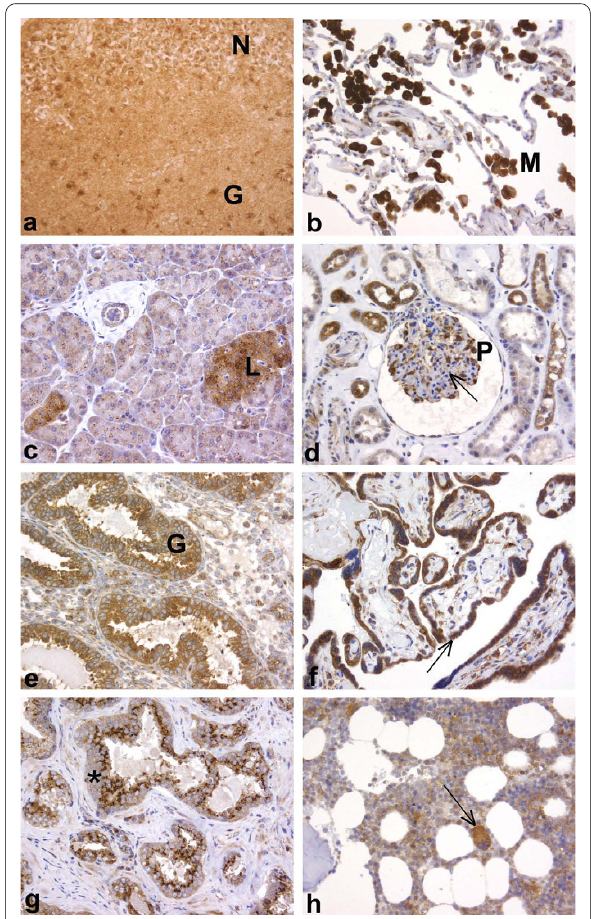
Figure 3 Immunohistochemical analysis of FMNL2 in human tis- sues . a) In the hippocampus, both neurons (N) and glial cells (G) ex- press FMNL2 strongly. b) In the lung, FMNL2 expression is strong in macrophages (M), but weak in alveolar epithelium. c) The exocrine pancreas stains weakly and granularly for FMNL2. The neuroendocrine cells in the Langerhans islets (L) stain strongly. d) In the kidney, glom- erular mesangial cells (arrow) do not expess FMNL2. In contrast, podo- cytes (P) and part of the tubules express FMNL2. e) In secretory endometrium, FMNL2 expression is strong in glandular epithelium (G), but weak in the stromal cells. f) In the placenta, trophoblasts (arrow) ex- press FMNL2 strongly. g) In the prostate, epithelial cells stain intensely, with an apical perinuclear dot (asterisk). h) In the bone marrow, the strongest FMNL2 expression is seen in megakaryocytes (arrow). ( a - h original magnification × 200)